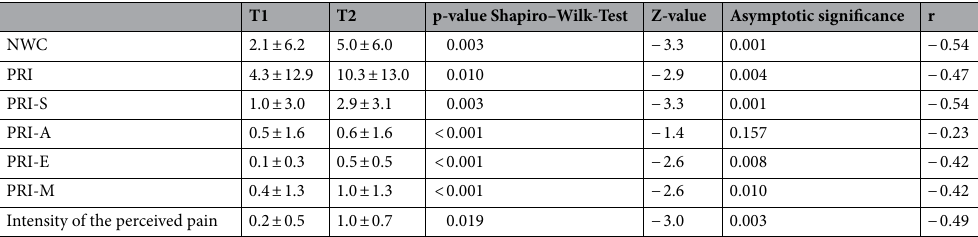
Table 1. Statistics of McGill Pain Questionnaire for T1 and T2. Values for T1 and T2 are presented as mean ± standard deviation. NWC number of words chosen, PRI total pain rating index, PRI-A affective pain, PRI-E evaluative pain, PRI-M other pain, PRI-S sensory